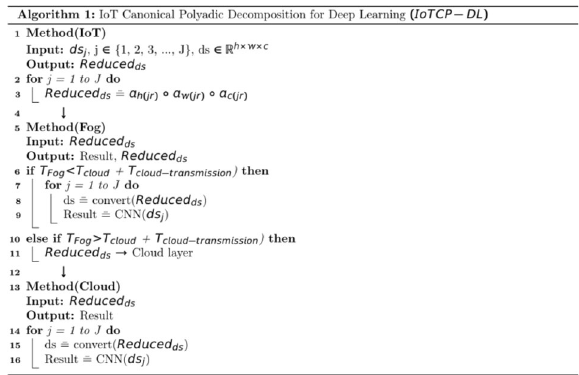
Algorithm 1: IoT Canonical Polyadic Decomposition for Deep Learning (IoTCP_DL)